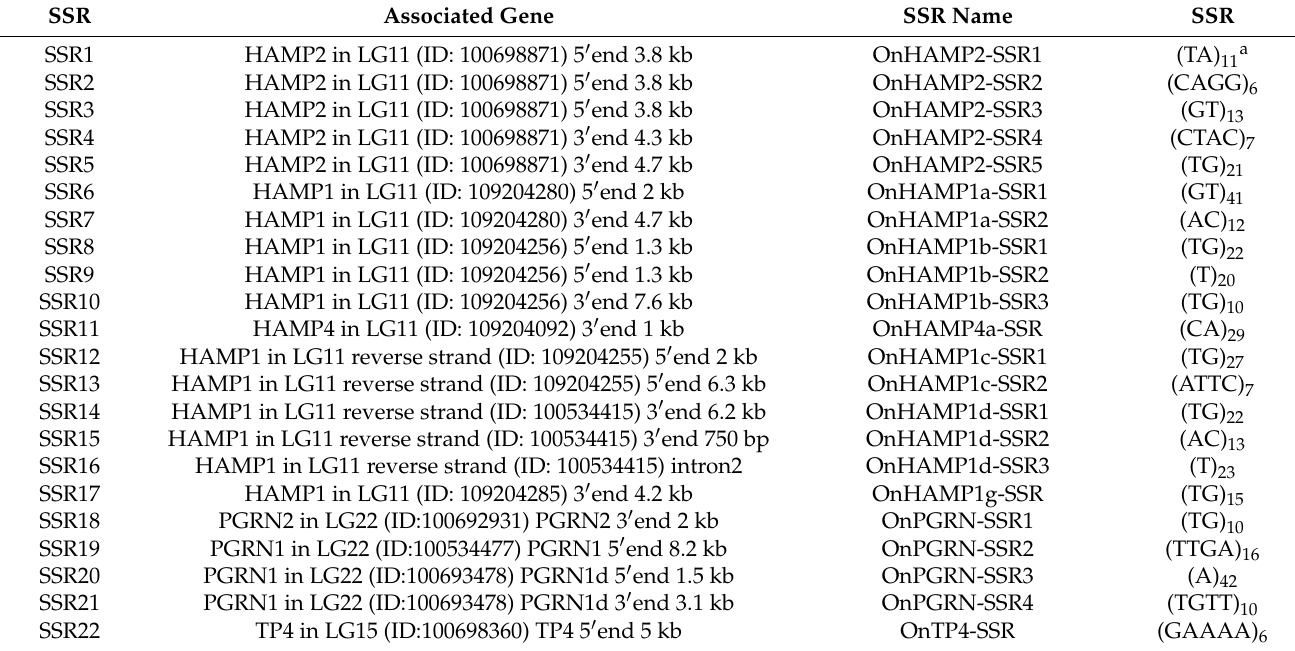
Table 1. Disease-resistance-associated microsatellites. Total of 22 SSRs, including 17 linked to the hamp gene family, 4 linked to the short type pgrn family, and 1 linked to the tilapia piscidin family. Associated